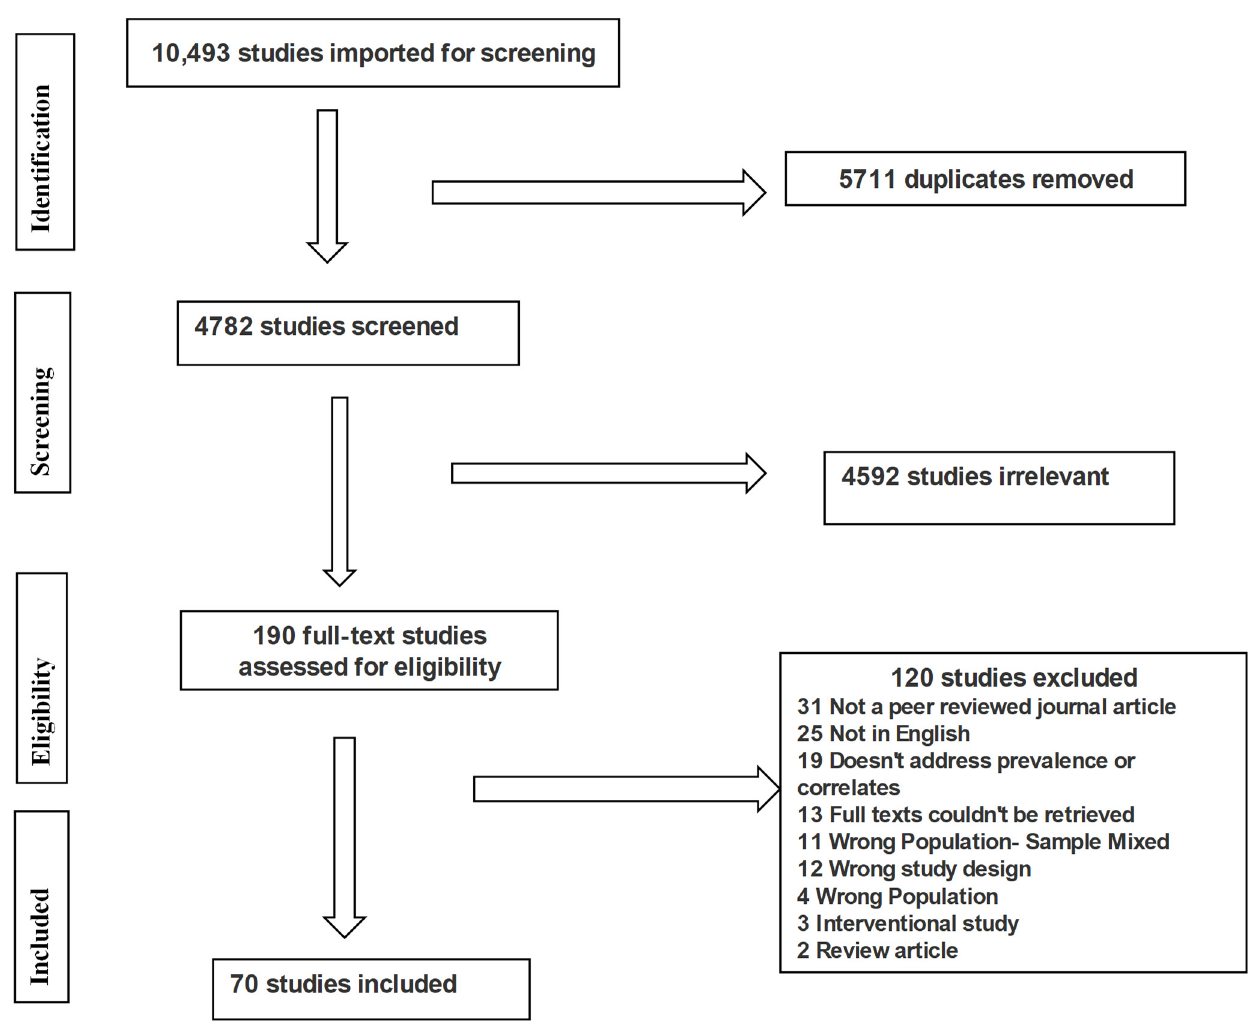
Figure 1. PRISMA flow chart.